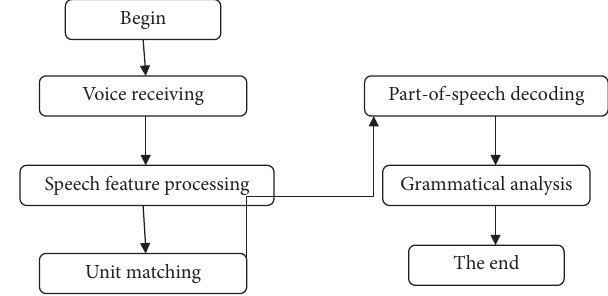
Figure 6: Software function design process.